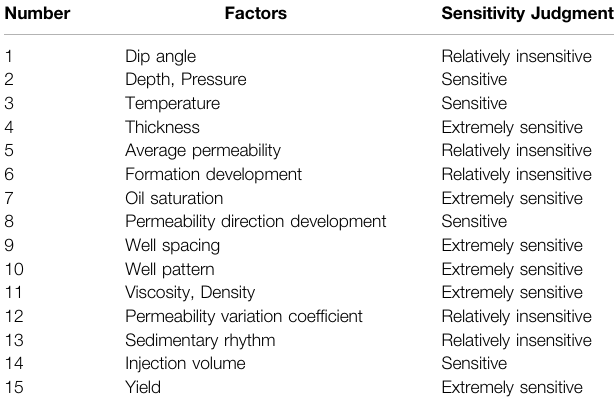
TABLE6| CO 2 -drivenreservoirscreeningindexweightingvaluesandbestvalues/ worst values used for reservoir index normalization in the Daqing Oil fi